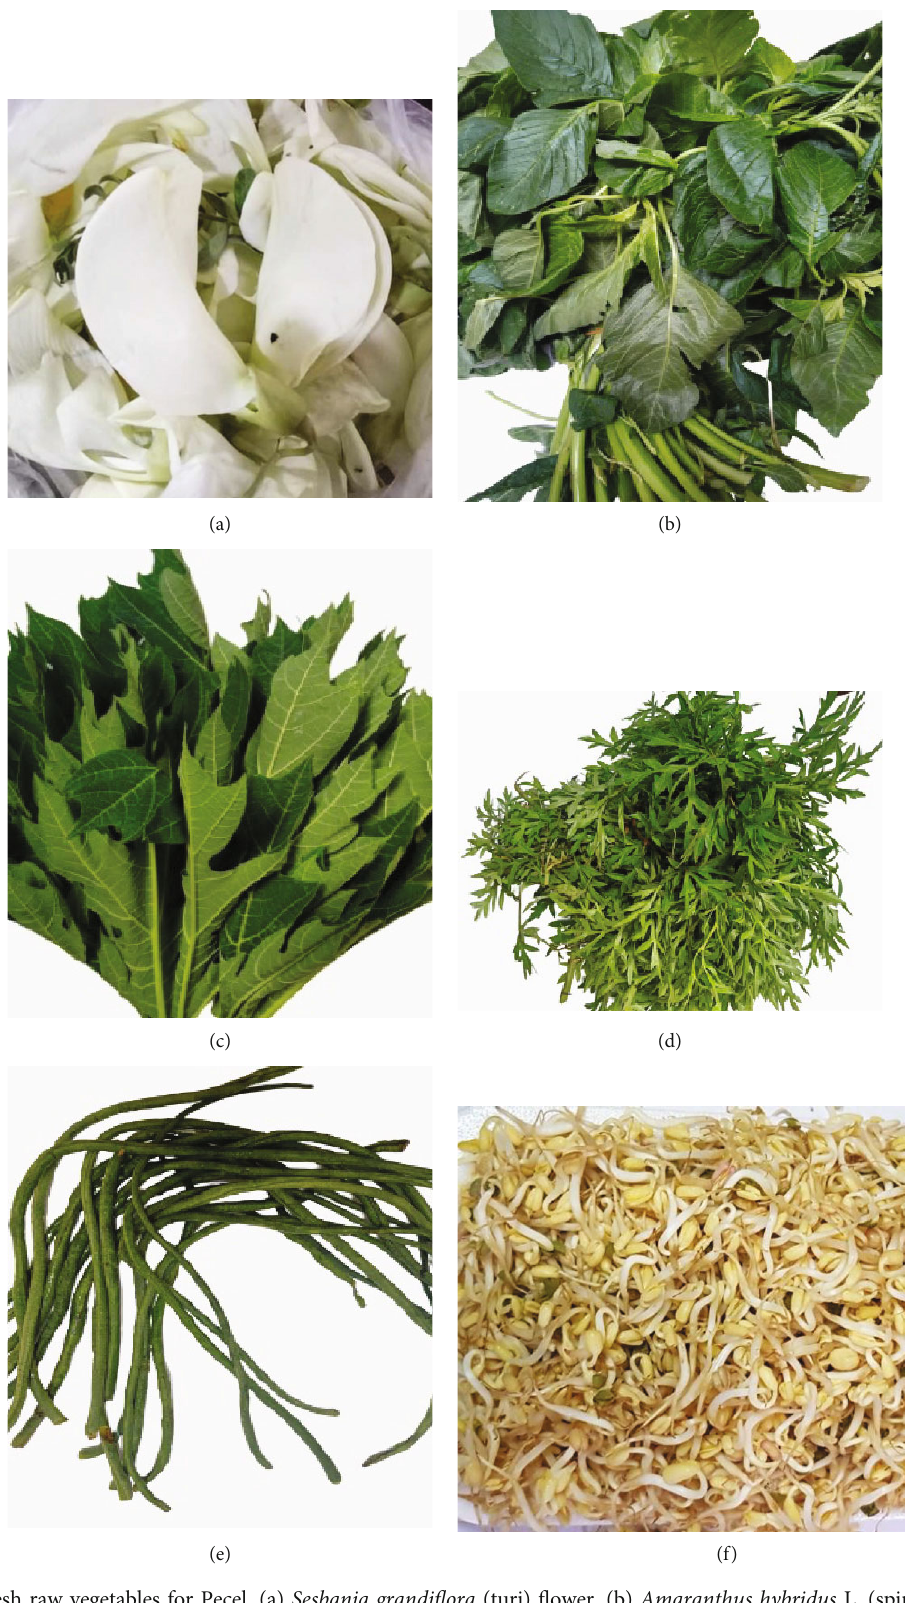
Figure 1: Fresh raw vegetables for Pecel. (a) Sesbania grandi fl ora (turi) fl ower, (b) Amaranthus hybridus L. (spinach), (c) Carica papaya (papaya) leaves, (d) Cosmos caudatus L . (kenikir) leaves, (e) Vigna unguiculata ssp. Sesquipedalis (yard-long beans), and f. Vigna radiata (mung-bean)